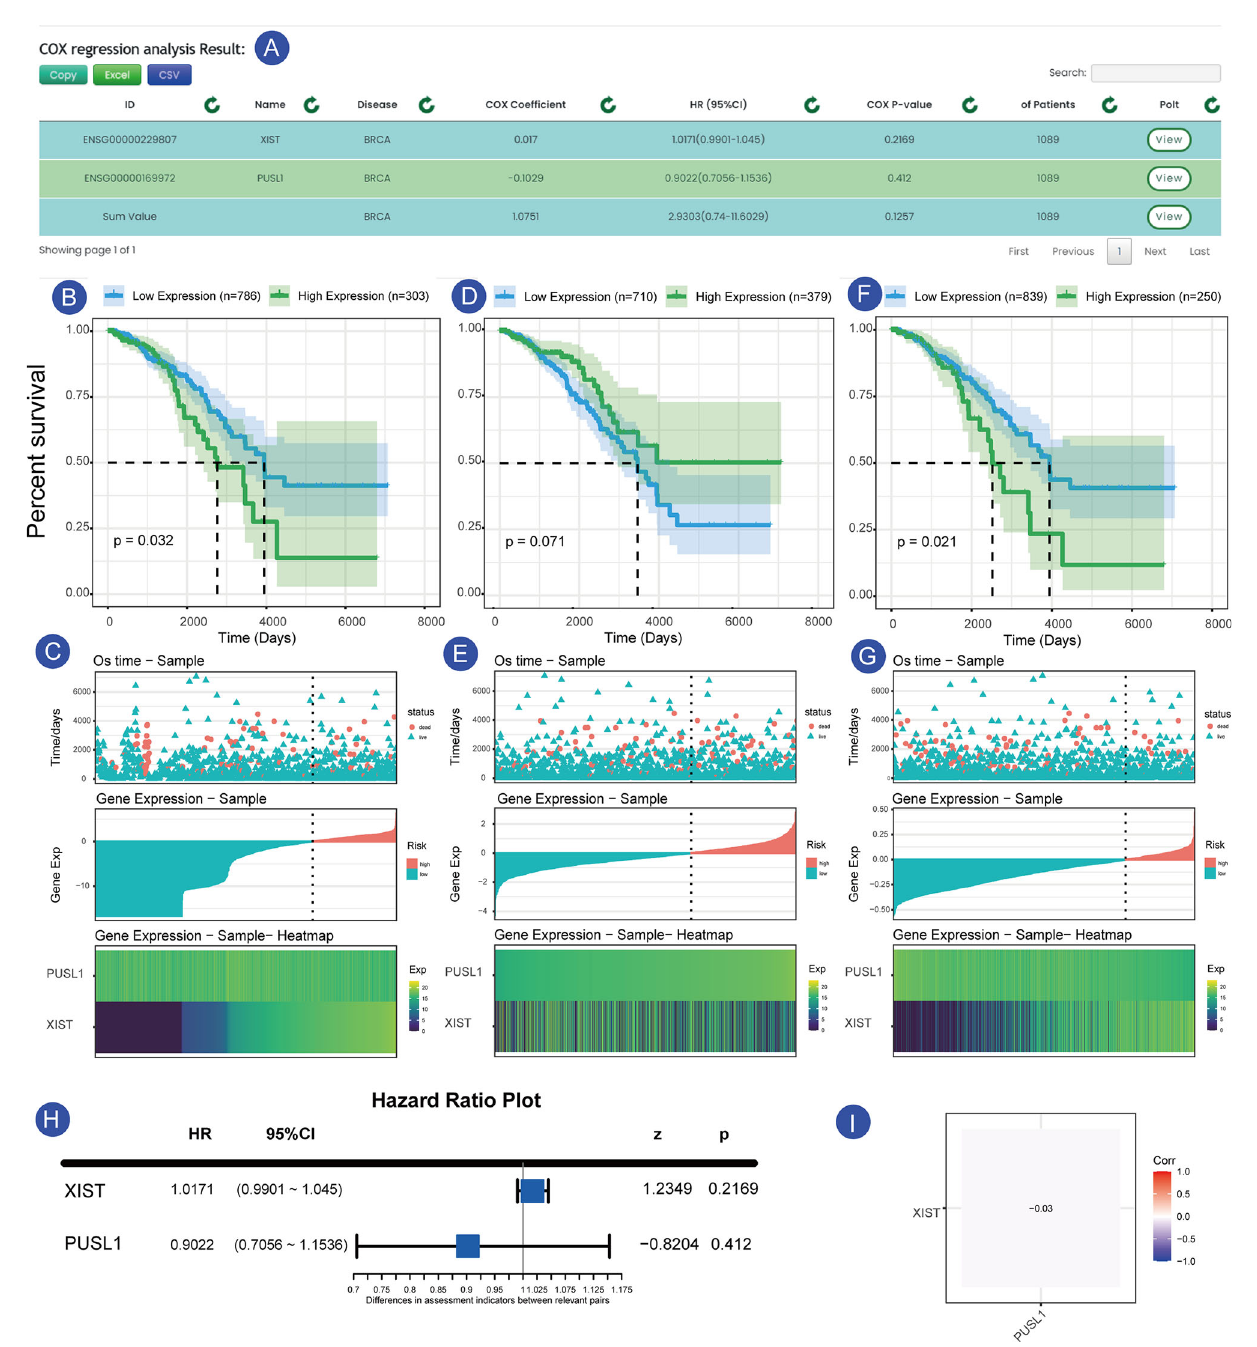
FIGURE 4 | Prognosis of XIST and PUSL1 in the sample set GSE42568. (A) shows the results of the prognostic analysis of XIST and PUSL1. (B, C) show the KM survival curves and survival time-gene expression association plots for XIST, respectively. (D, E) show KM survival and the survival time-gene expression association plots for PUSL1, respectively. (F, G) KM survival curves and survival time-gene expression association plots for the SUM group (integrated data for XIST and PUSL1), respectively.Forest plot of the two genes in the breast cancer sample set. (H) Expression correlation plot between the XIST and PUSL1 genes, which shows that the two genes affect the survival status of patients independently of each other (I)